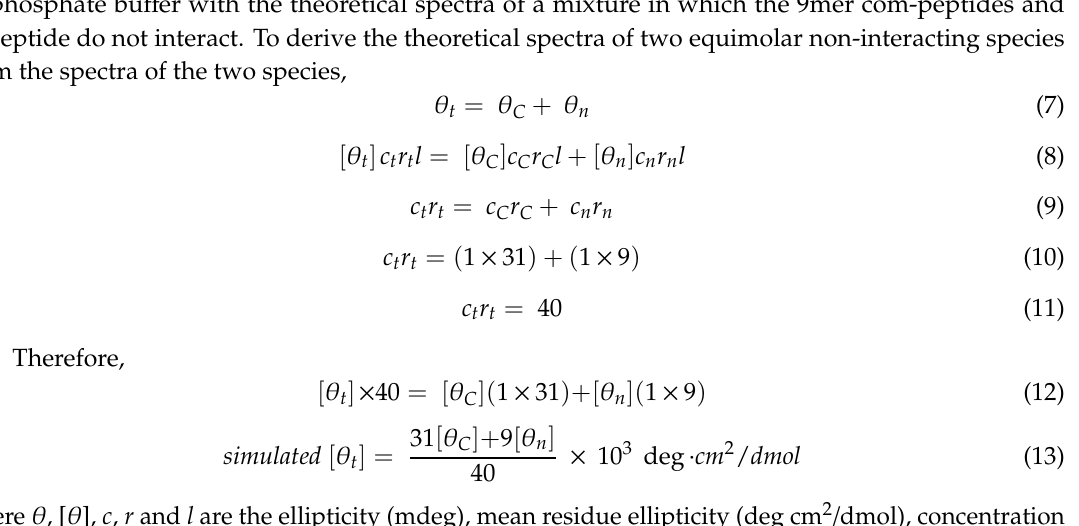
Figure 7. CD spectral time course of ( A ) C-peptide, ( B ) Trp-D, ( C ) Lys-D, and ( D ) Lys-L. The inset in spectrum A shows the change in C-peptide over time–(left) clear at the start, (right) colloidal after 53 days. The CD spectra show that C-peptide changes slowly over time, but the three 9mer com-peptides remain essentially unchanged over the same period.